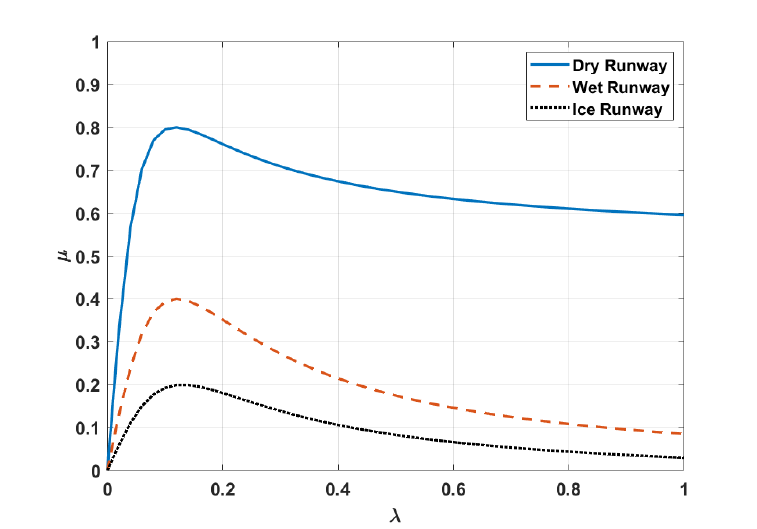
Figure 3. Relationship between adhesion coefficient µ and slip rate λ